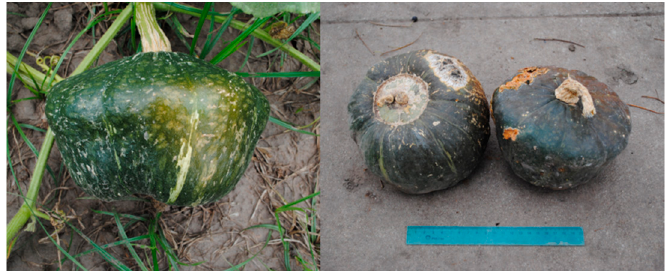
Figure 7. Fruits of Buttercup cultivar ‐ group, left unripe fruit in plant, right , mature fruits, one up ‐ side ‐ down showing the crown. Blue ruler 20 cm.